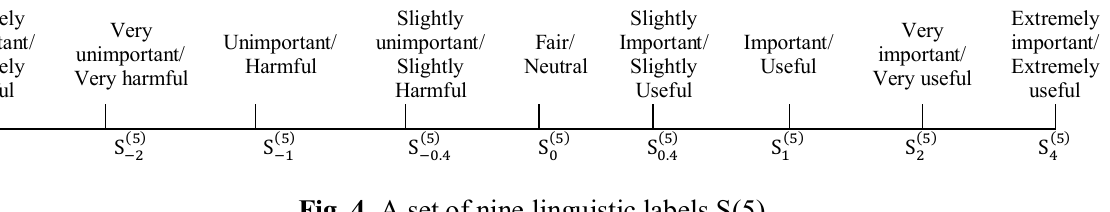
Fig. 3. A set of seven linguistic labels S(4)